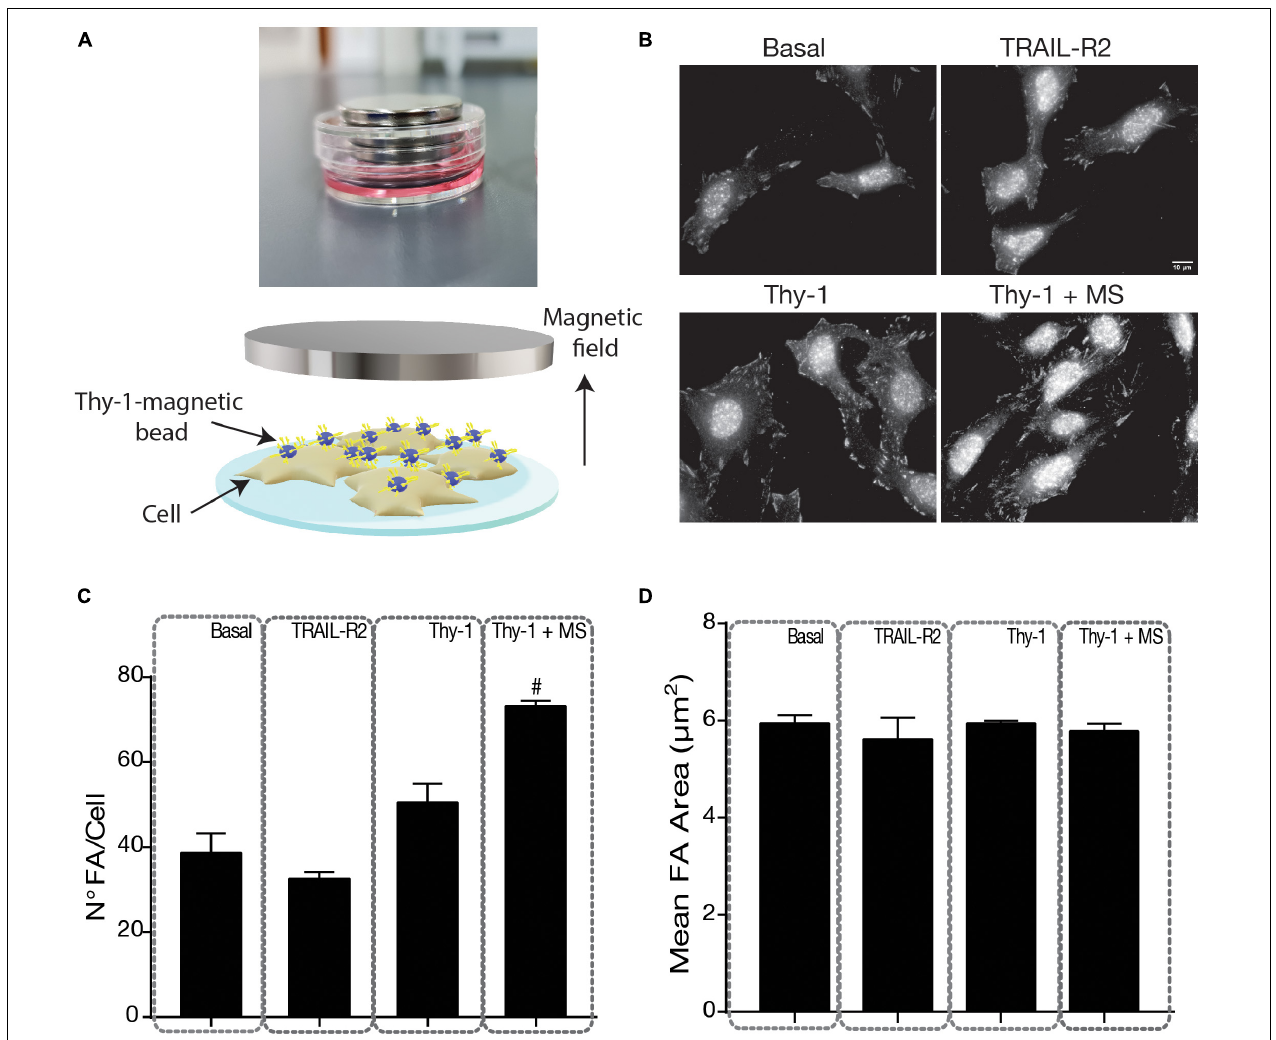
FIGURE 1 | Indirect Immunofluorescence of focal adhesions in DITNC1 cells. (A) Image to the top shows the tissue culture plate with the magnets, which create the magnetic field. The scheme illustrates details of the experimental approach. Cells were plated on coverslips (light blue surface) and incubated with serum-free medium for 30 min. DITNC1 cells (beige) were stimulated with TRAIL-R2- (as a negative control) or Thy-1-coated Protein A-conjugated magnetic beads (blue spheres with yellow sticks), with or without mechanical stress (MS) applied by a magnet (gray) for 5 min. (B) Focal Adhesions (FA) were stained with an antibody against phospho-tyrosine, followed by a secondary antibody. Magnification bar = 10 µ m. (C,D) Values in the graph are the mean + s.e.m. from at least 30 cells that were measured per condition in each experiment ( n = 3) of the number (N ◦ ) of FA per cell (C) and the average area ( µ m 2 ) of the FA (D) . Statistical significance was calculated using the Kruskal–Wallis non-parametric test with Dunn’s multiple comparison. # p < 0.05, compared with the Thy-1